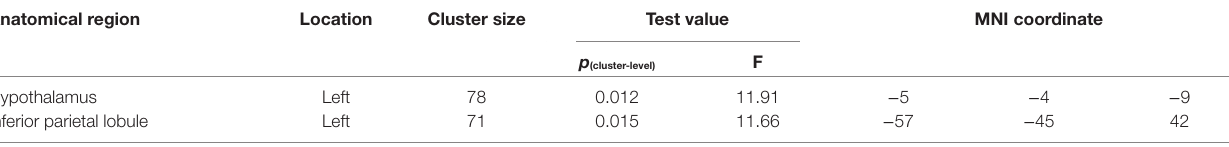
FigUre 1 | significant gMV differences were observed among PTsD, OcD, saD and controls in left hypothalamus (a) and left iPl (B) shown projected onto the gray matter template built using DarTel . Significant correlations were also observed between GMV in left hypothalamus and HAM-A (c) and HAM-D (D) scores. ( P cluster-level < 0.05 with a minimum cluster